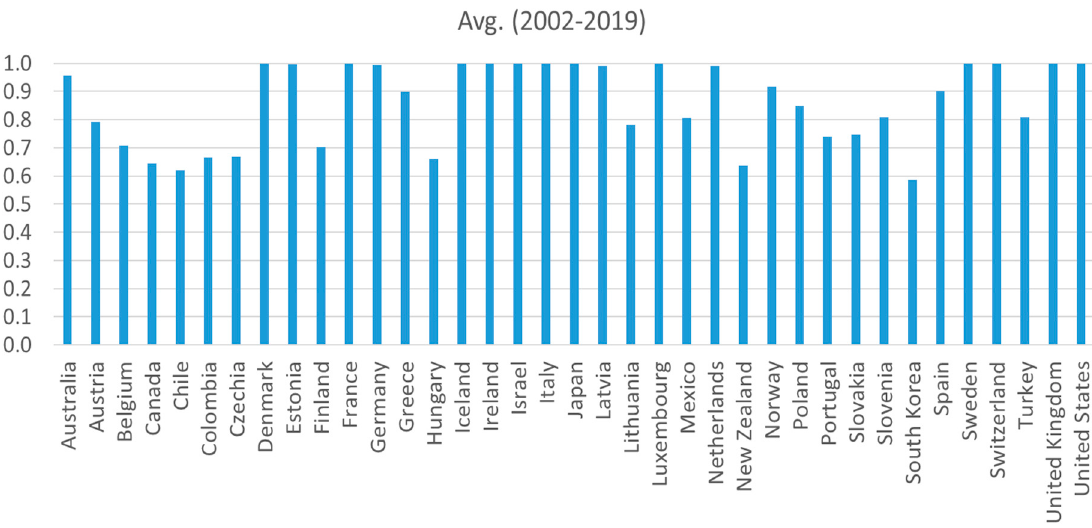
Figure 5 . Average efficiency ( WOE ) of OECD nations (2002–2019). Note: This figure was prepared by the authors.